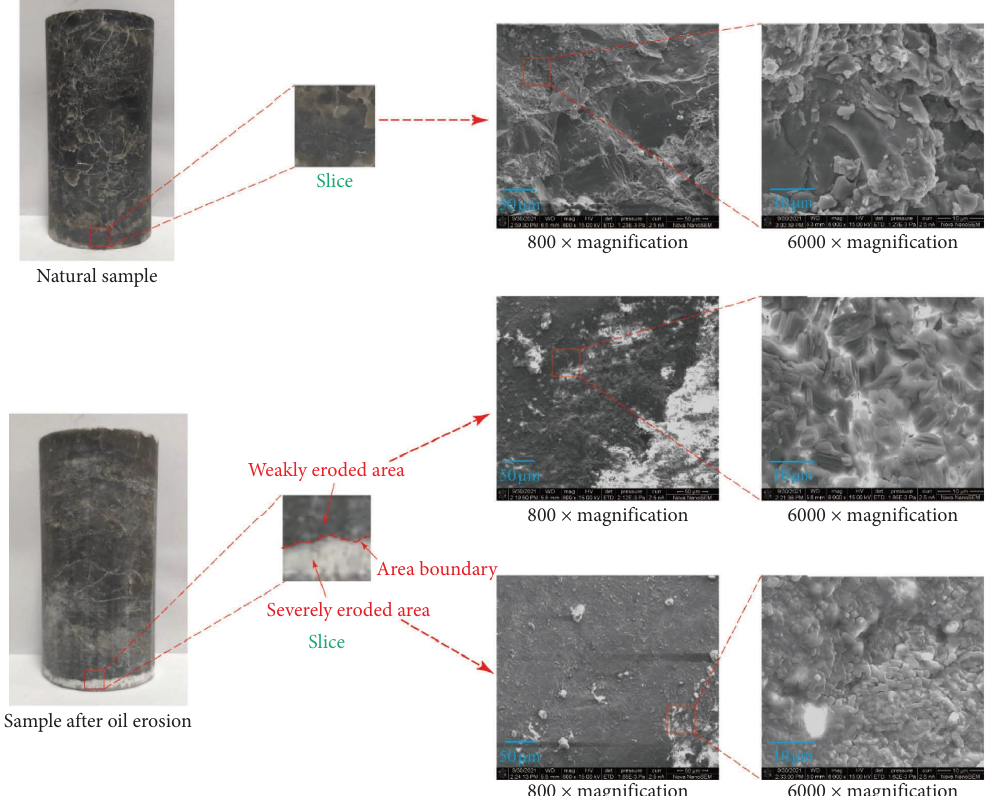
Figure 12: Analysis of microscope mechanism before and after oil erosion.